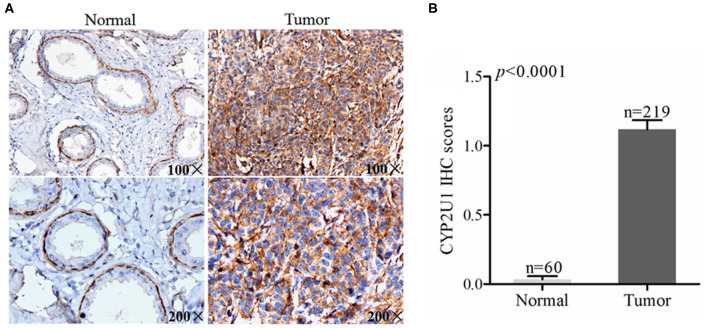
Analyses of cytoplasm CYP2U1 expression in normal breast and tumor tissues. (A) Representative images of CYP2U1 protein abundance in normal and breast tumortissues are shown. (B) Semi-quantitative result is displayed as the mean ± SEM.